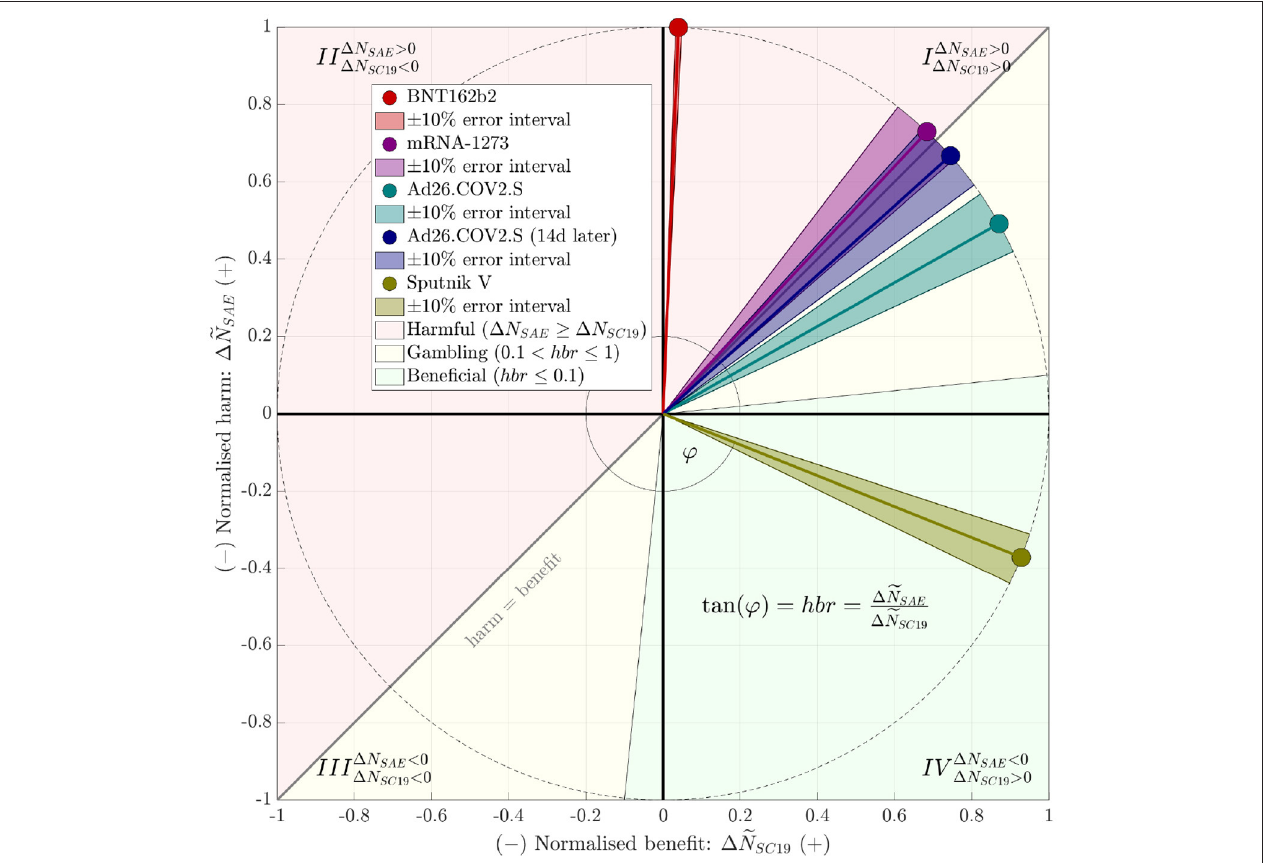
FIGURE 1 | Juxtaposition, within a harm-benefit diagram, of the vaccines’ observed (short-term) harm-to-benefit ratios ( hbr ) according to Table 1 . To make both juxtaposed, hbr -contributing differences, 1 N SAE : = N SAE , vac − N SAE , com (harm events) and 1 N SC 19 : = N SC 19, com − N SC 19, vac (benefit events), comparable, we N SAE : = 1 N SAE N SC 19 : = 1 N SC 19 normalized these numbers as 1 and 1 , respectively, for then projecting them on the unit circle. Note that the hbr is q 1 N 2 SAE + 1 N 2 SC 19 q 1 N 2 SAE + 1 N 2 SC 19 e e N SAE = atan2 (cid:16) 1 , with “atan2 () ” denoting the four-quadrant inverse tangent function ( 12). The red-shaded uniquely represented by the angle ϕ = atan2 (cid:16) 1 N SAE 1 N SC 19 (cid:17) e 1 N SC 19 (cid:17) area above the “harm = benefit”, i.e., hbr = 1 line marks the harmfully unbalanced area: hbr > 1 indicates harm to exceed benefit in the corresponding studies. The e green-shaded area marks what we would consider the “medically beneficial” (also: balanced or acceptable, respectively) area of hbr ≤ 0.1 (while 1 N SC 19 > 1 N SAE ), at least in the short term. The yellow-shaded area marks the remaining cases, which we would term “gambling” conditions, because they yield only just less short-term harm than benefit, and a vaccinated human bets on the unknown long-term harms being lower than those in the short term. Dark-shaded sectors around hbr pointers indicate a 10% uncertainty interval, which was constructed by disturbing numerator and denominator by 10% each and choosing the maximum and minimum resulting hbr . For the “SputnikV” study ( 9) data, a (beneficial) negative hbr indicates a positive benefit alongside with a negative harm, i.e., lesser SAE in the vaccinated than in the comparison group. Note that a negative (and then harmful) hbr might also have occurred by doing harm ( 1 N SAE > 0) while being accompanied by a negative benefit ( III nd quadrant), which had luckily not been observed in these